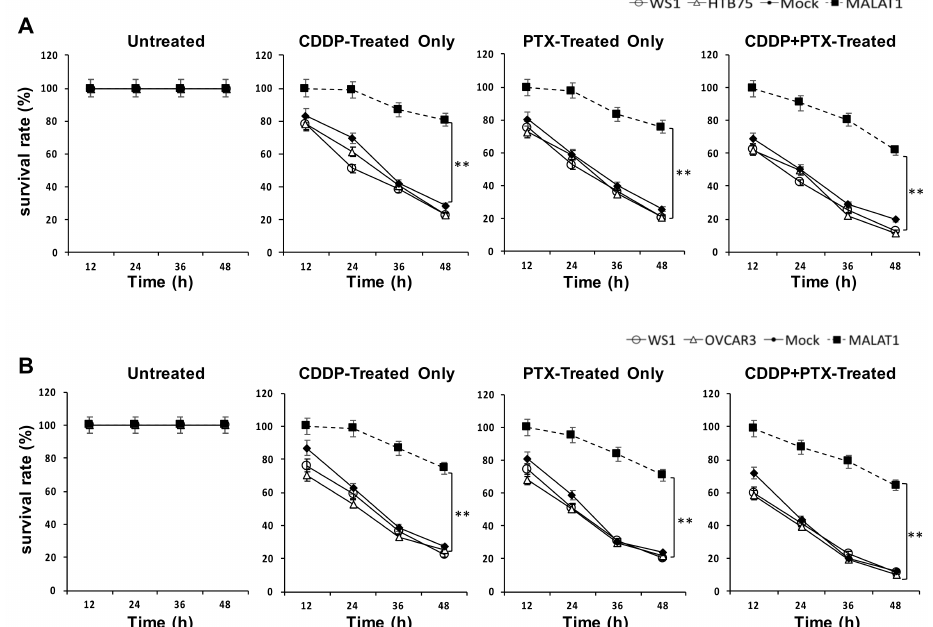
Figure 2. MALAT1 expression contributes to drug-resistance capacities. Effects of MALAT1 overex- pression with ( A ) 1.0 µ M CDDP alone, 1.2 nM PTX alone, or their combination in HTB75 cells, and ( B ) 1.2 µ M CDDP alone, 1.2 nM PTX alone, or their combination in OVCAR3 cells were evaluated by cell viability assays after 12, 24, 36, and 48 h of drug treatment. Data shown were acquired from three independent experiments. ** p <